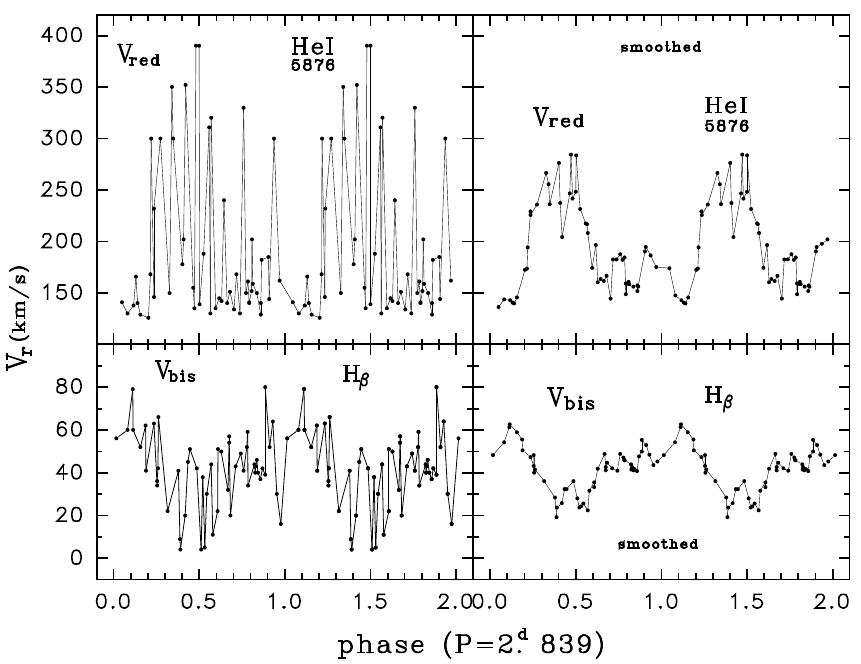
Figure 7. Phase dependencies of the parameters V bis (H β ) and V red (He I λ 5876) from the HD259431 spectra, constructed for the period P = 2.839d ( left ) and smoothed over five data points ( right ). Using the time when the parameter V red (He I λ 5876) reaches its maximum as the initial phase φ = 0, we can construct the phase variations of the profiles of some other CS lines in the spectrum of HD 259431. Figure 8 illustrates such variability for the lines H δ , He I λ